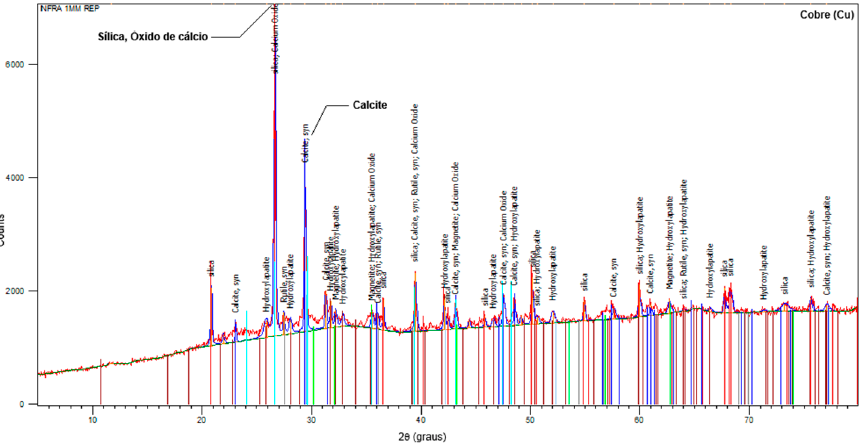
Figure 1. XRD pattern for MIBA.